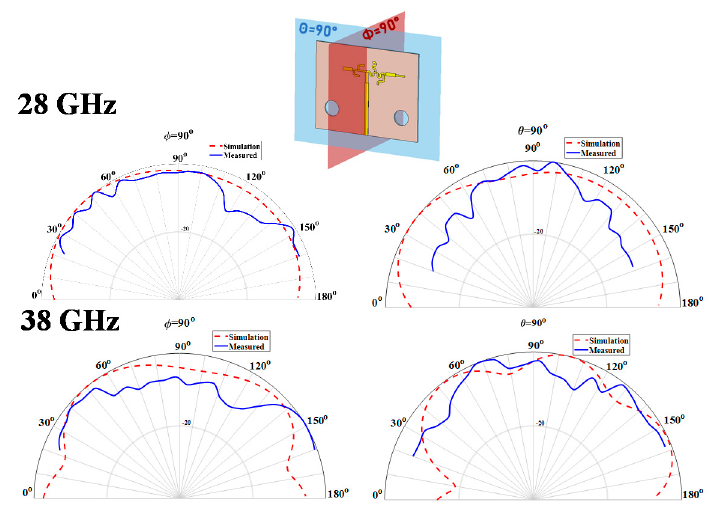
Figure 15. Simulated and Measured Normalized Radiation Pattern of the Dual-Band Antenna at 28 GHz and 38 GHz.